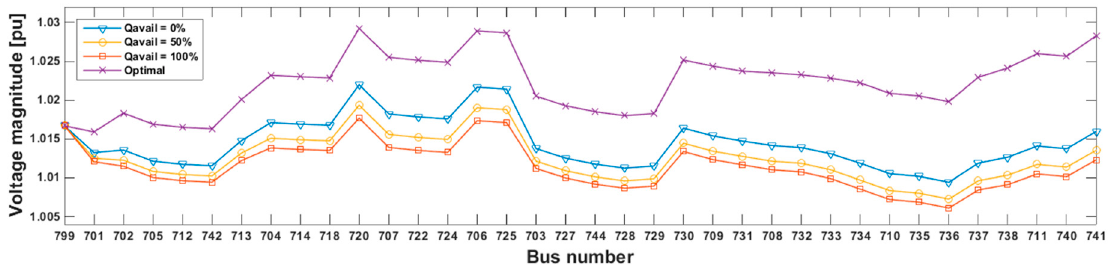
Figure 5. Voltage profiles for heavy load condition while all DG units output full power.